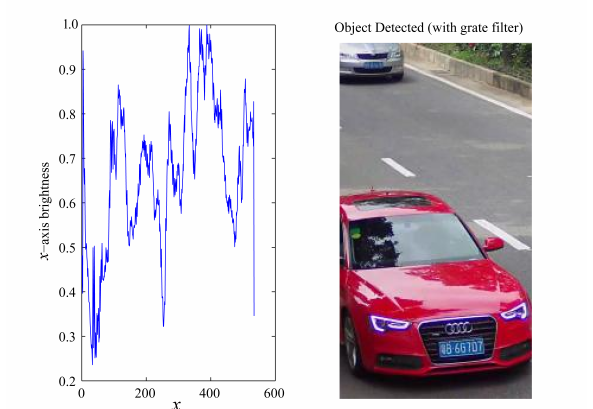
Fig. 6 Flow chat showing the process of our proposed background subtraction method.